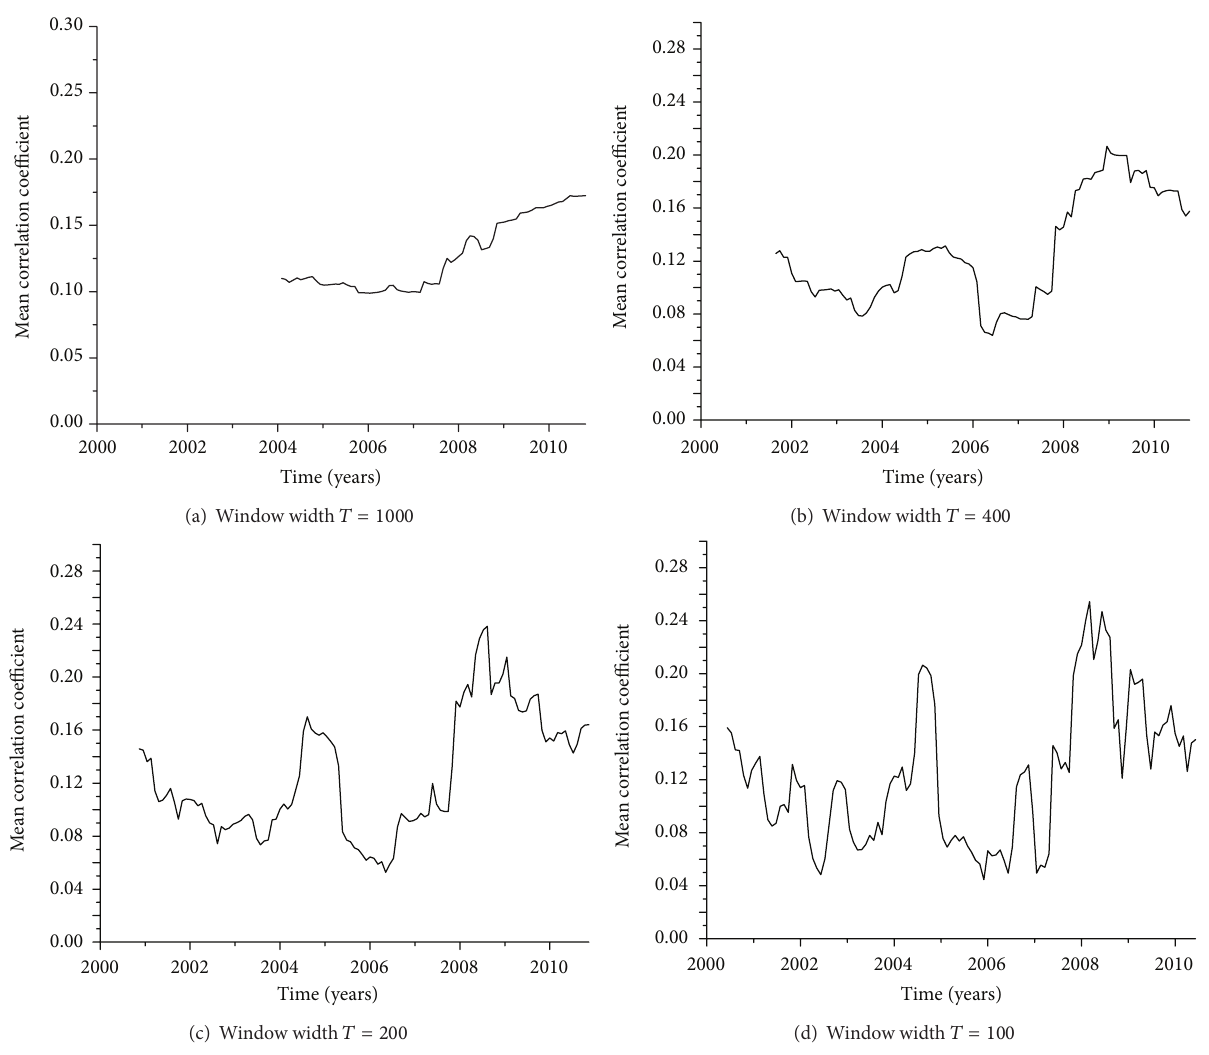
Figure 2: Some experiment results of 𝜌(𝑡) as a function of